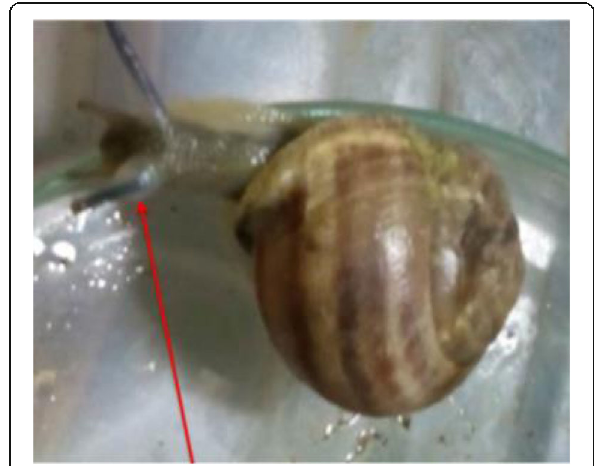
Fig. 10 Infected adult E. vermiculata infected with nematode showing a swollen